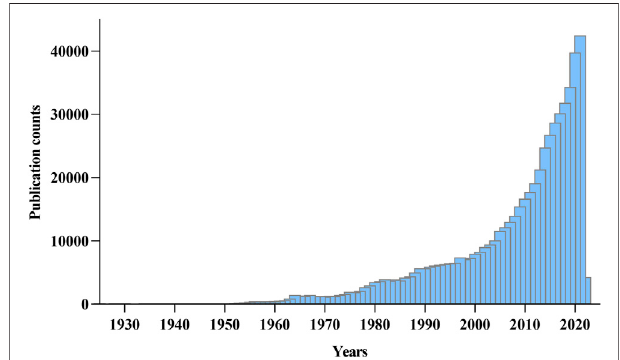
FIGURE 1 | Yearly growth of aging research across biomedical and medical fi elds.ThenumberofresearchpublicationswasviewedfromPubMed on 1st February 2022. The search term was “ Aging ” and “ Ageing.